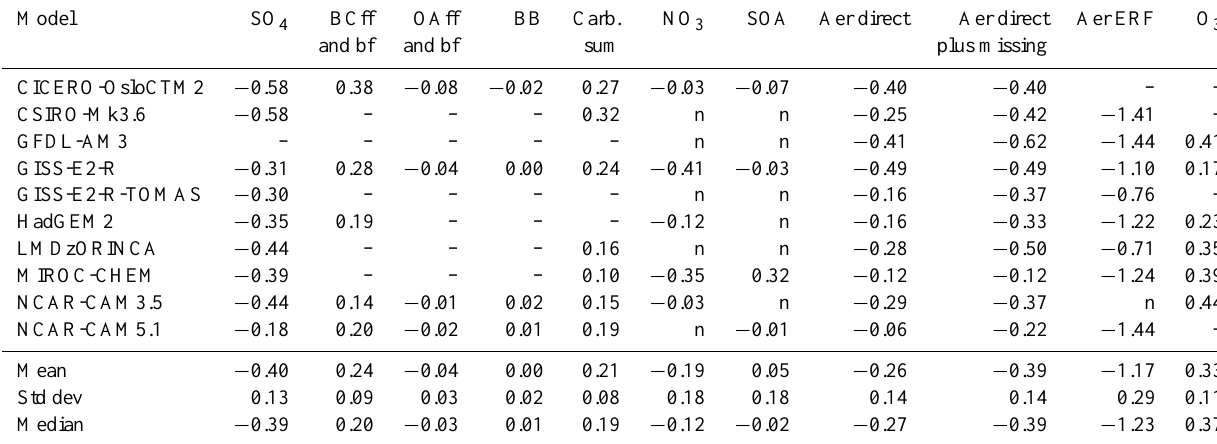
Table 7. Evaluation of 1850 to 2000 RF by component in each model. Model